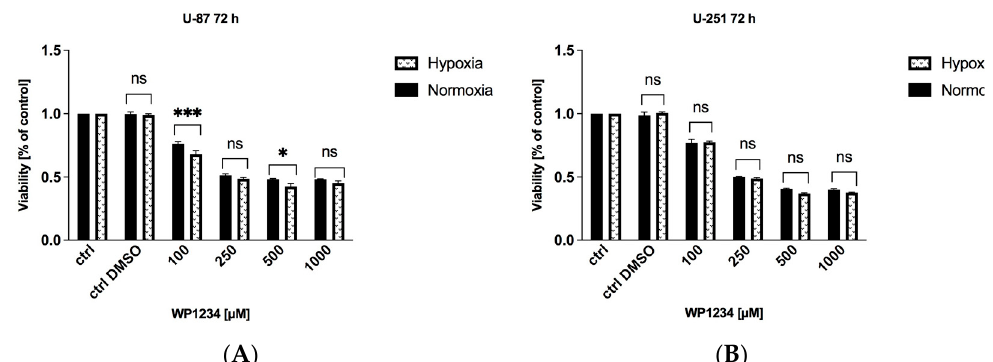
Figure 5. ( A ) U-87 and ( B ) U-251 cells viability after 72 h treatment with various concentrations of WP1234 (100–1000 μ M) in normoxia and hypoxia-like (DMOG + Rho) conditions. Significant differences between the treatment means and control (untreated cells) value are indicated by * p < 0.05, ** p < 0.01, *** p < 0.001; (ns—no significance).